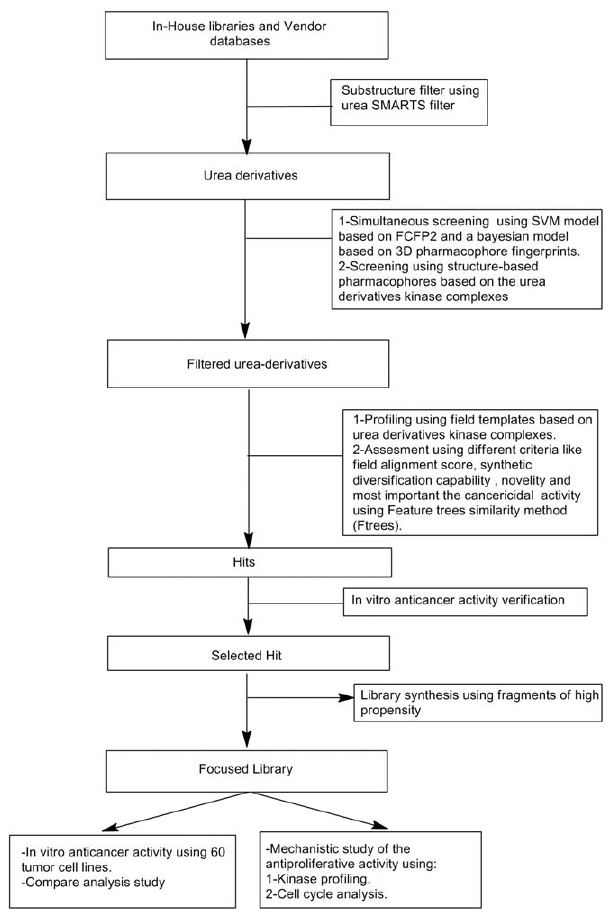
Figure 2. General workflow of the study which includes the computational procedure of ligand profiling using multiple field templates, the protocol of cancericidal verification using features similarity method, the in vitro cytotoxicity assays and finally the mechanistic study using high-throughput kinase profiling and cell cycle